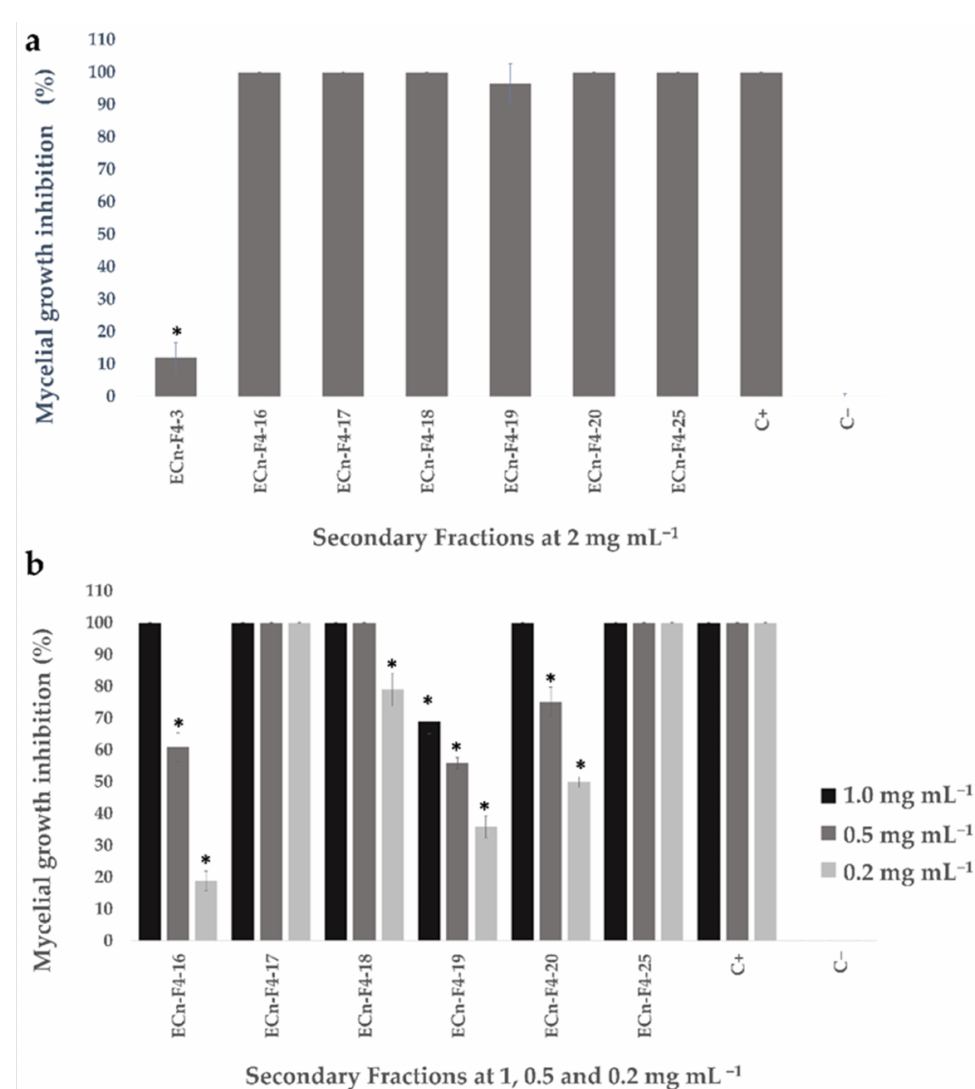
Figure 2. Mycelial growth inhibition displayed by secondary fractions from ECn-F4 against F. kuroshium . ( a ) Percentage of inhibition of F. kuroshium exposed to ECn-F4 secondary fractions at 2 mg mL − 1 . Data are the average ± standard error ( n = 3). Asterisk (*) indicates significant difference compared to positive control (thiabendazole 2 mg mL − 1 ; C+), p < 0.05, Kruskall-Wallis, Mann-Whitney post-hoc test with Bonferroni adjustment. The negative control (C − ) was the extract vehicle (H 2 O- MeOH in a 15:85 ratio). Supporting material is shown in Supplementary Figure S3. ( b ) Percentage of inhibition of F. kuroshium exposed to secondary fractions at 1, 0.5 and 0.2 mg mL − 1 . Data are the average ± standard error ( n = 3). Asterisk (*) indicates significant difference compared to positive control (thiabendazole 2 mg mL − 1 ; C+), p < 0.05, Kruskall-Wallis, Mann-Whitney post-hoc test with Bonferroni adjustment. The negative control (C − ) was the vehicle (H 2 O-MeOH in a 15:85